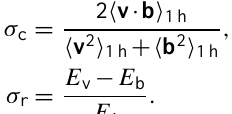
( h E v /E b i 5AU = [ 0 . 64 ± 0 . 01 ] ). Furthermore, according to Fig. 3 the results relative to σ c and σ r well agree with